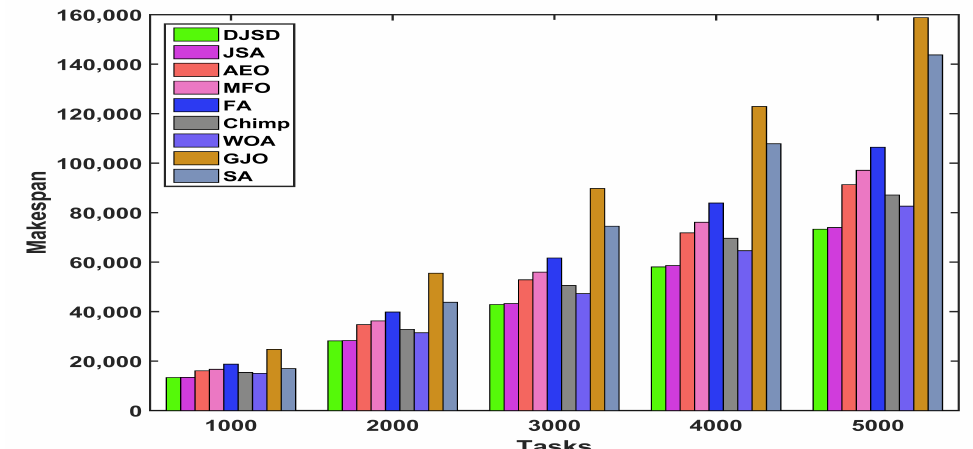
Figure 9. Average makespan for HPC2N real